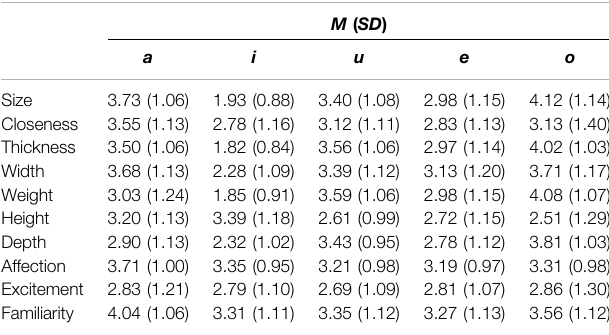
TABLE 1 | Mean scores and standard deviations of subjective evaluations of fi ve written Japanese vowels.